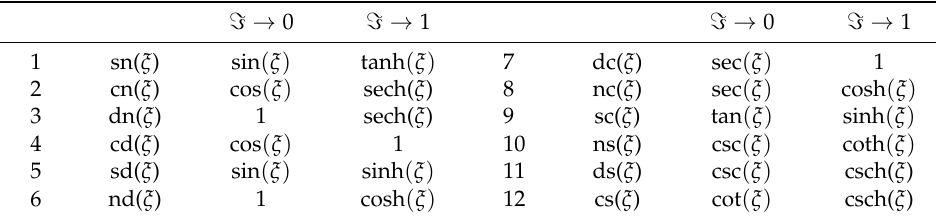
Table 2. JEFS for (cid:61) → 0 and (cid:61) →